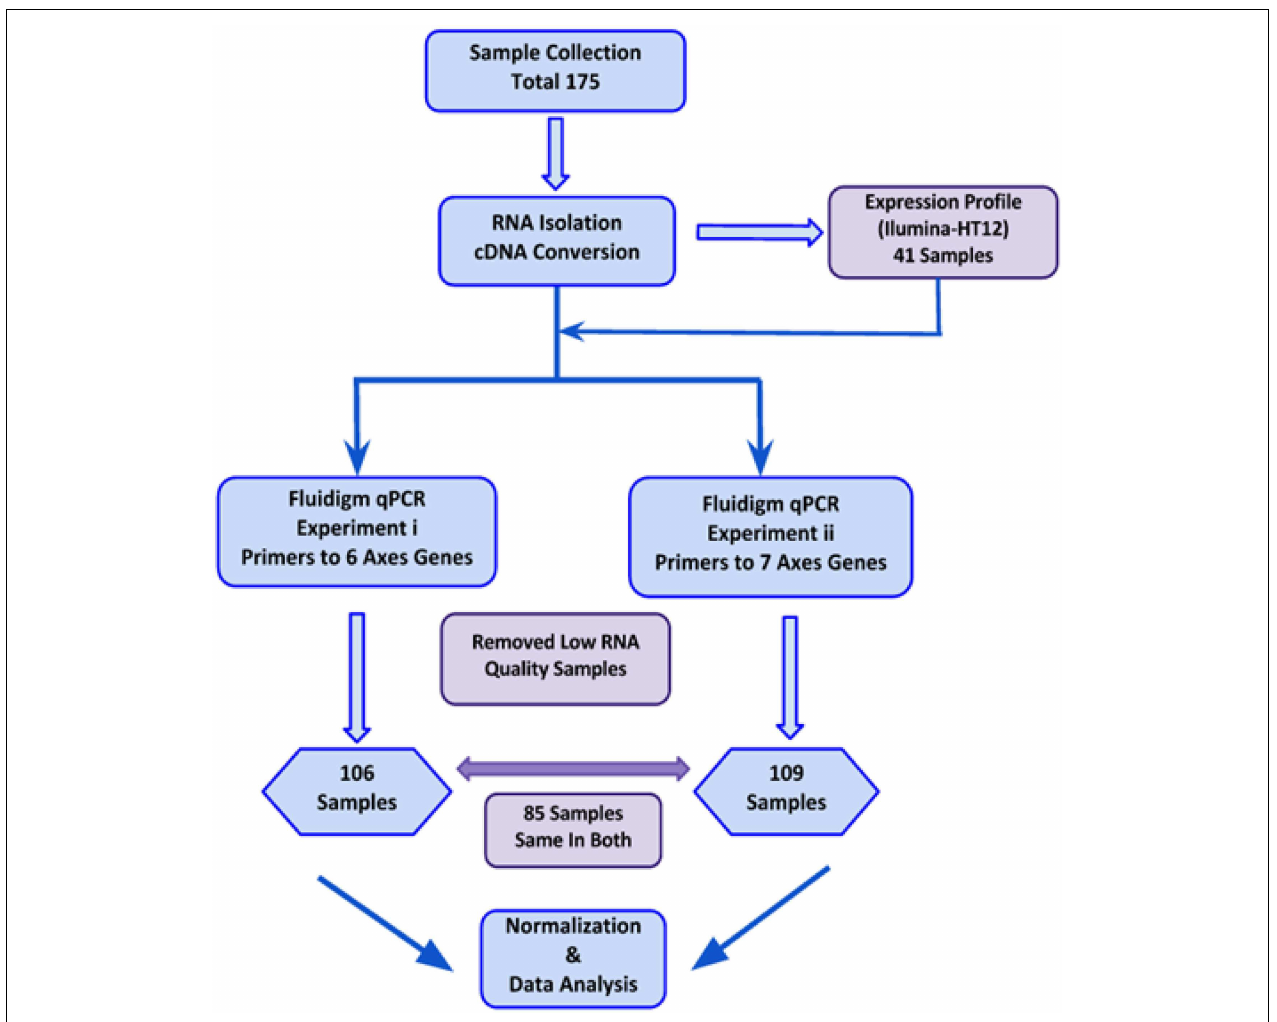
FIGUREA2 | Flow diagram of sampling